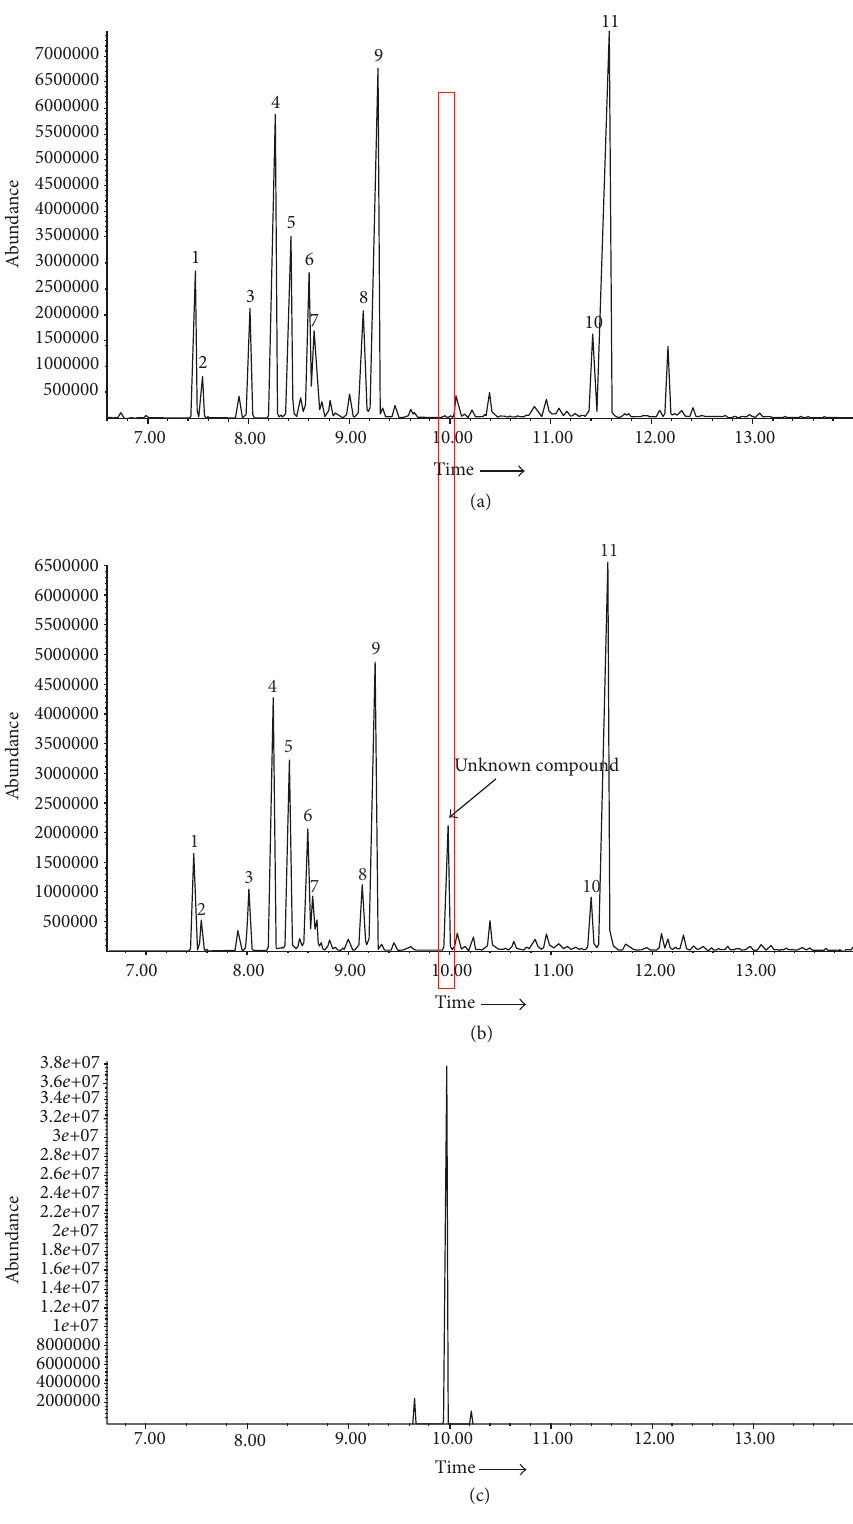
Figure 1: GC-MS analysis. (a) GC-MS analysis of fresh patchouli oil with one-year storage time. (b) GC-MS analysis of stale patchouli oil with ten-year storage time. Numbers indicated on peaks corresponded to those in Table 2. (c) GC-MS analysis of the unknown compound isolated from stale patchouli oil with ten-year storage